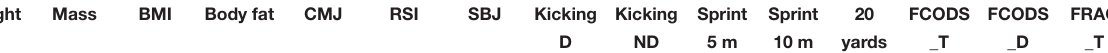
TABLE 6 | Pearson’s correlation coefficients between studied variables. Height Mass BMI Body fat CMJ RSI SBJ Kicking Kicking Sprint Sprint 20 FCODS FCODS FRAG D ND 5 m 10 m